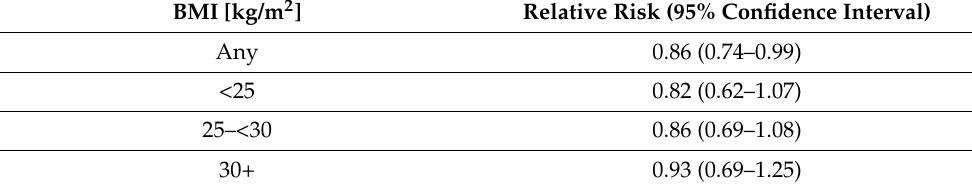
Table 3. Effects of vitamin D3 supplementation on risk of advanced cancer among those with incident cancer according to BMI in the VITAL study (derived from results extracted from references [4,5] and shown in Table